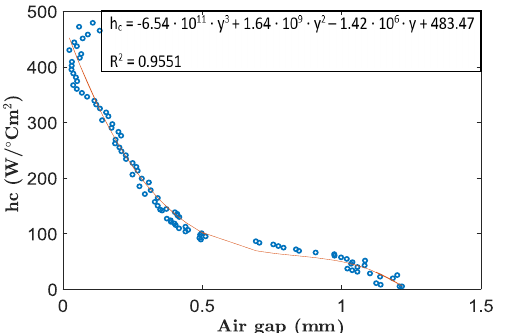
Figure 6. Relation between the thermal conductance coefficient and the air gap. The relation and its equation, where y is the distance between the glass and the base of the pan, are shown graphically. The R-squared value of the regression model is also presented.